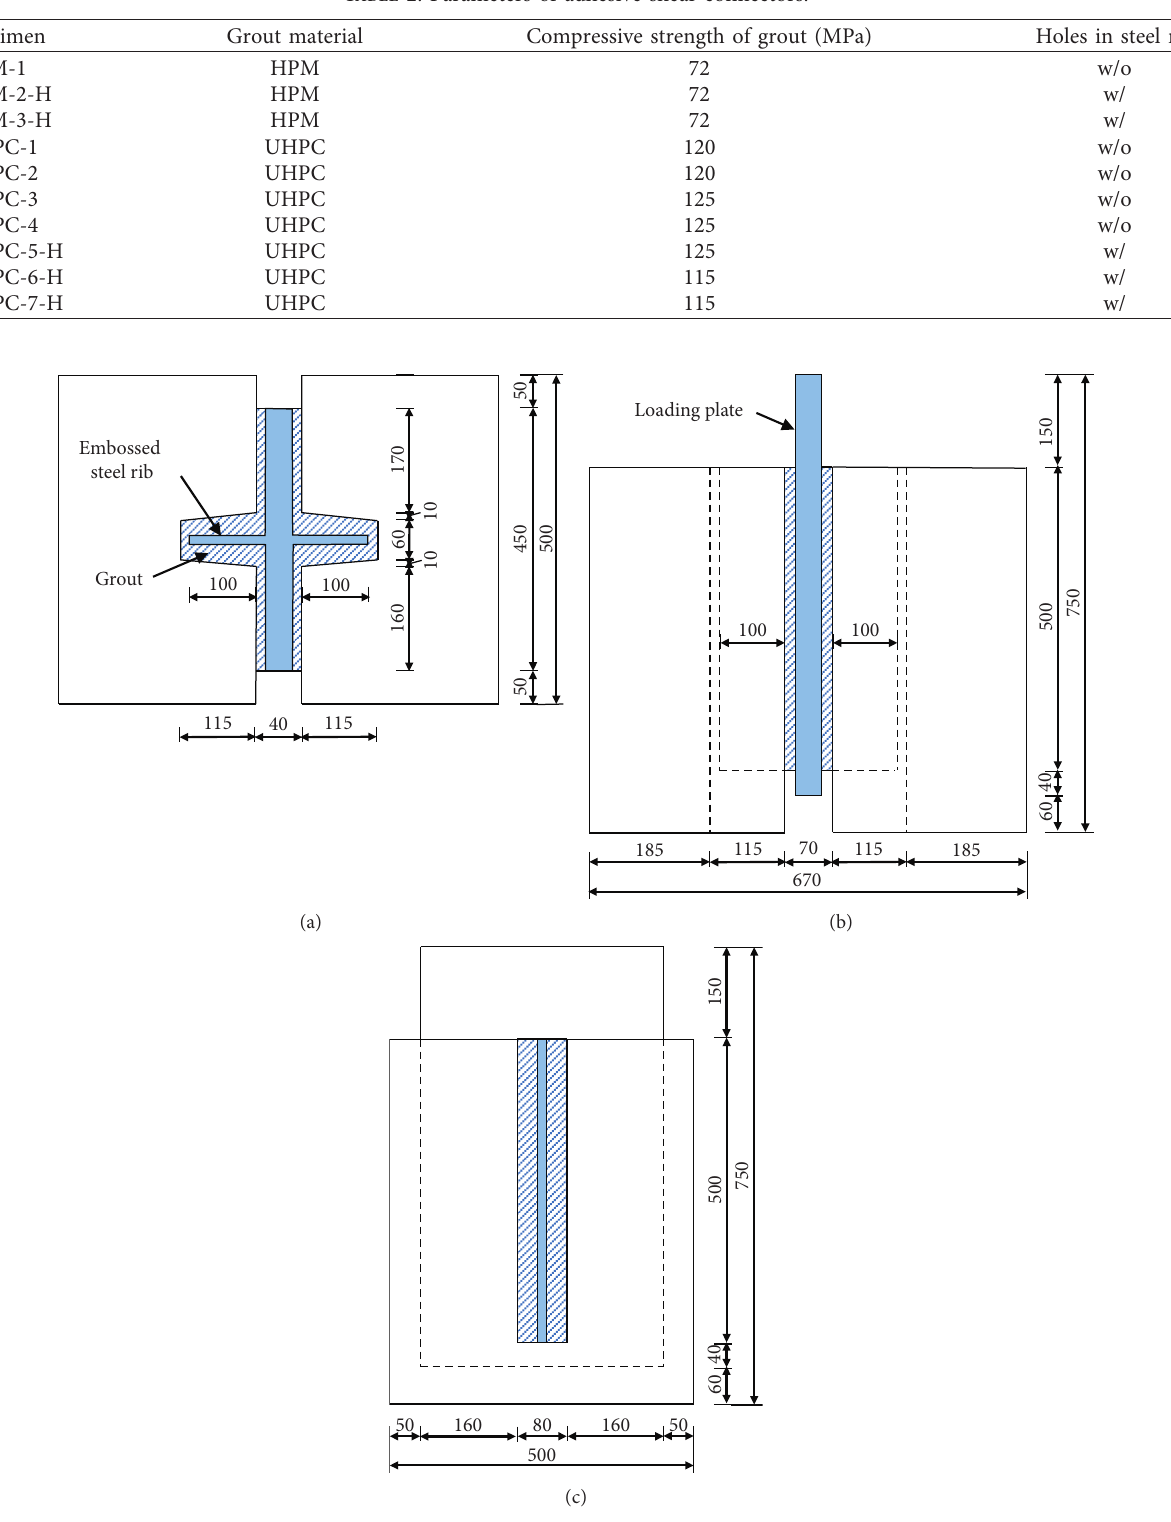
Figure 9: Geometry of push-out test specimens (dimensions in mm). (a) Plan view. (b) Front view. (c) Side